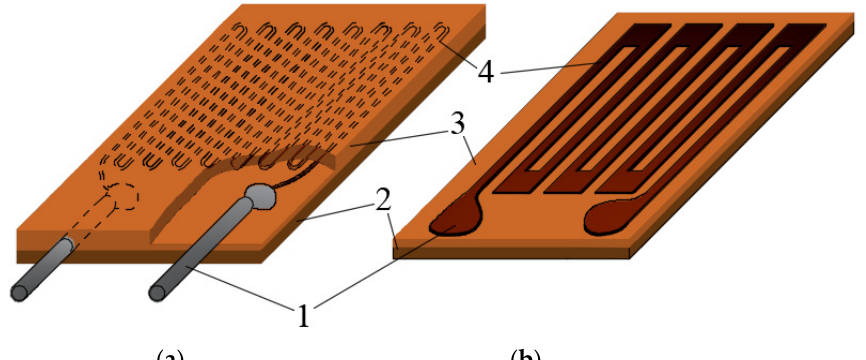
Figure 1. Strain gauges: ( a )—with a wire sensitive element; ( b )—with a foil sensitive element; 1— output contacts; 2—base made of insulating material (substrate); 3—binder (glue); 4—the sensitive element of the strain gauge.